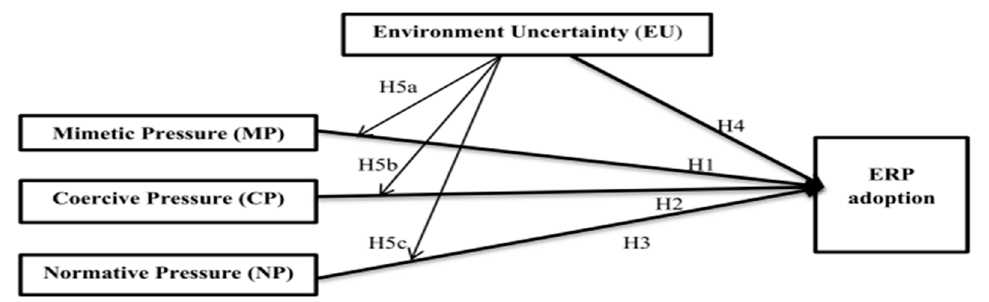
Figure 1. Research Figure 1. Research model.